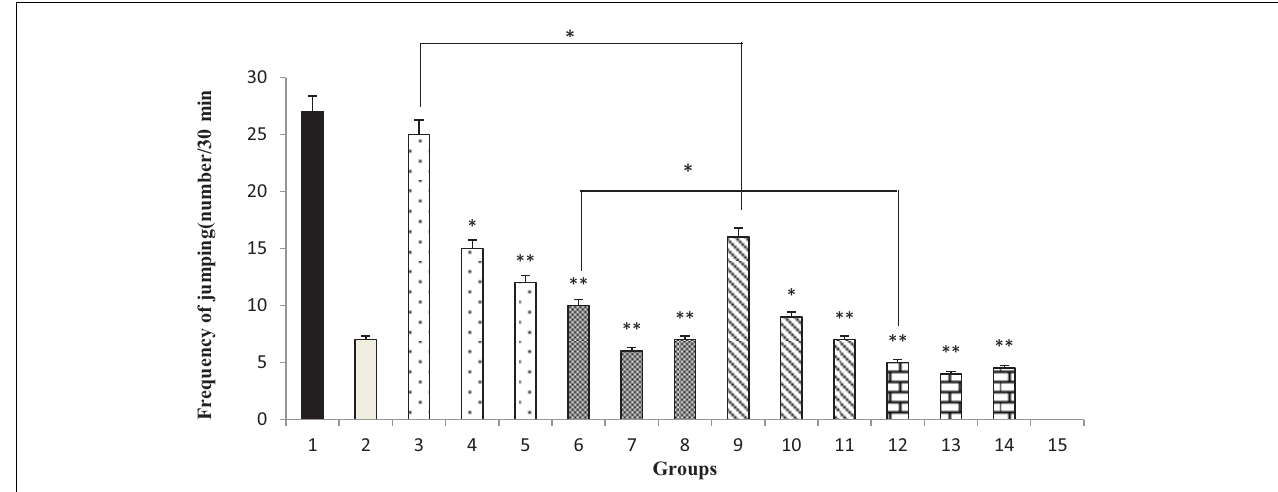
FIGURE 9 | The jumping frequency (number of jumping/30 min) in rats. Group 1; morphine-dependent rats (control). Group 2; morphine-dependent rats and coadministration of clonidine hydrochloride (0.2 mg/kg i.p.) (positive control). Groups 3, 4, and 5; morphine-dependent rats and the coadministration of 100, 200, and 300 mg/kg Thymbra spicata extract, respectively. Groups 6, 7, and 8; morphine-dependent rats and coadministration of 30, 60, and 90 mg/kg thymol, respectively. Groups 9, 10, and 11; morphine-dependent rats and coadministration of 100, 200, and 300 mg/kg extract nanopolymer, respectively. Groups 12, 13, and 14; morphine-dependent rats and coadministration of 30, 60, and 90 mg/kg thymol nanopolymer, respectively. Group 15; non-dependent rats (saline). Data are expressed as mean ± SEM. ∗ P < 0.01 vs. control, ∗∗ P < 0.001 vs. control.